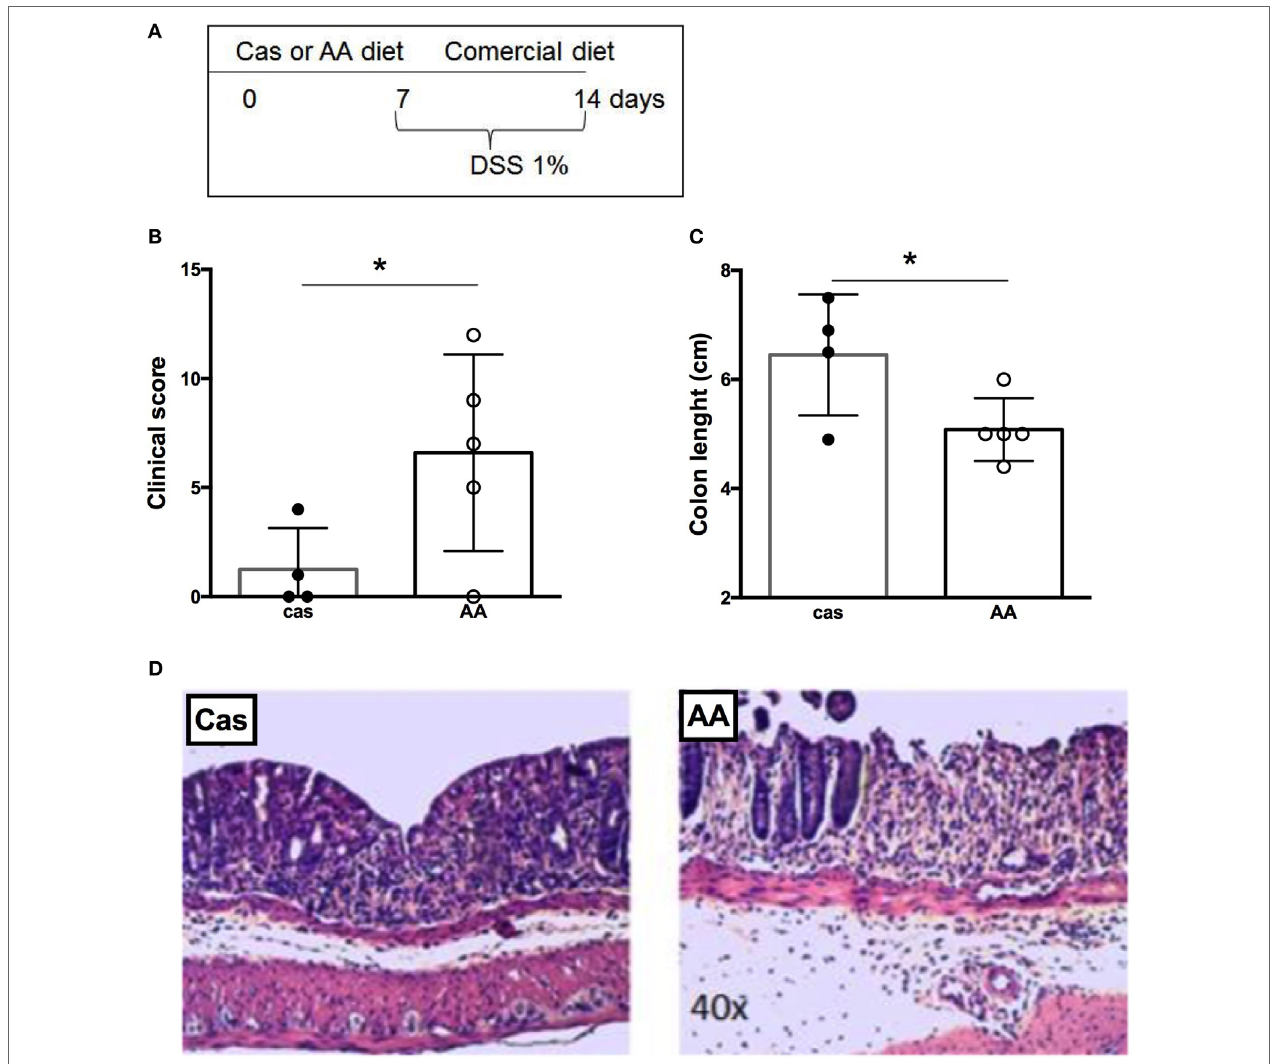
FigUre 6 | Histological evaluation of colitis development after dietary consumption. (a) C57BL/6 mice at 7–8 weeks of age received either casein-containing diet (CAS diet) or diet containing free amino acids (AA diet) for 7 days. Then, experimental diets were replaced by commercial mouse chow and colitis was induced by administration of 1% dextran sodium sulfate (DSS) for 7 days. During colitis development, mice received commercial chow. Clinical scores (b) were evaluated after colitis induction using a scoring system, which included loss of body weight, diarrhea, and presence of blood in the stools. Colon length (c) was evaluated after the DSS consumption. Representative images of CAS- and AA-fed mice after colitis induction (D) are shown. Statistical analysis was performed between CAS-fed and AA-fed group at the end of each experimental time point using Mann–Whitney test for non-parametric data. p <